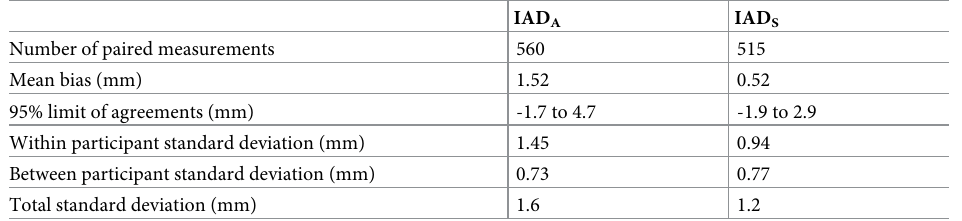
Table 1. Bland-Altman comparisons of the IAD A and IAD S against IAD M